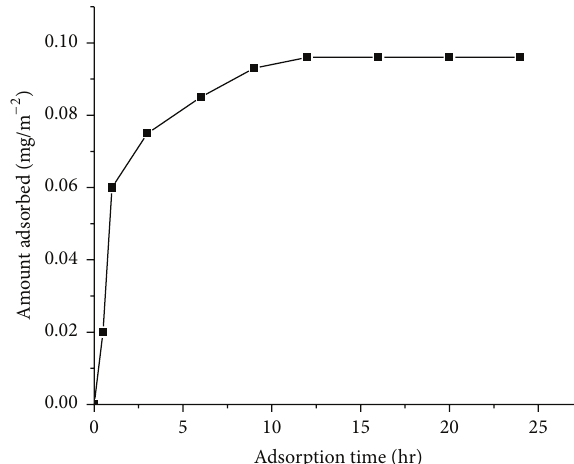
Figure 6: Adsorbed amount of PVP as a function of time. The error percentage was about 2.5.